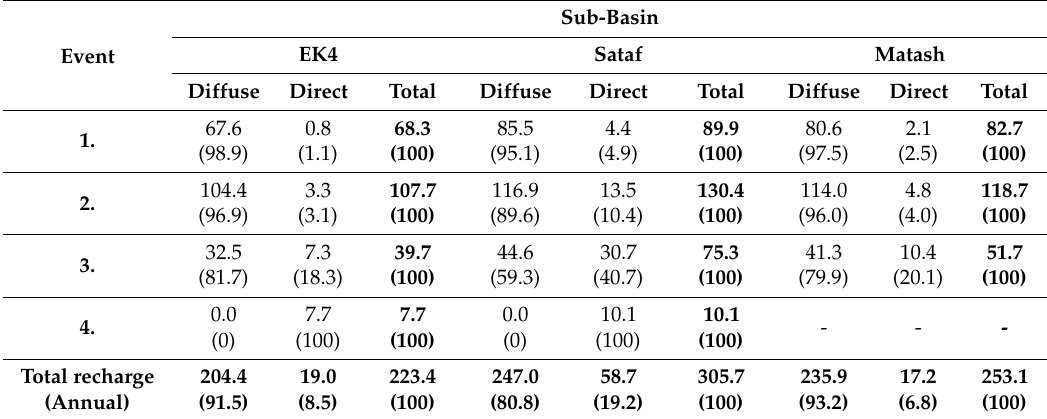
Table 3. Computed groundwater recharge depth (mm), and in parentheses, the percentages from the total recharge in each sub-basin during the study